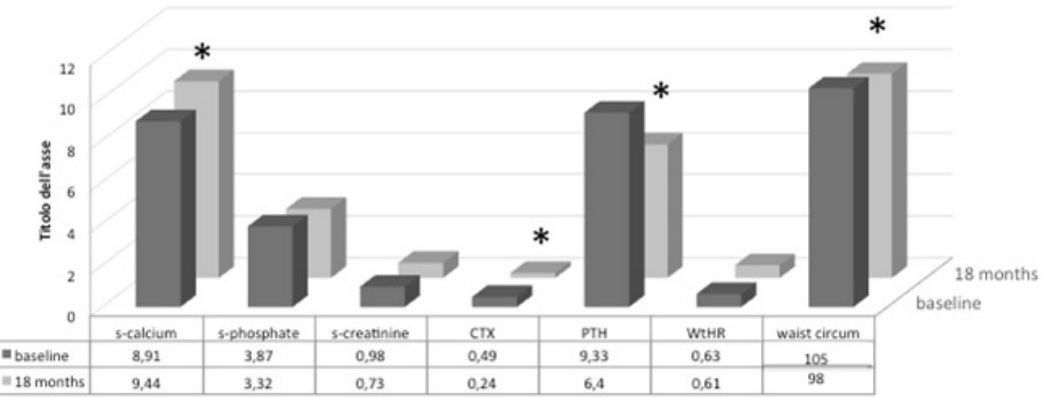
Figure 3. Main anthropometric and biochemical variables of monthly group at baseline and after 18 months of treatment; * p <